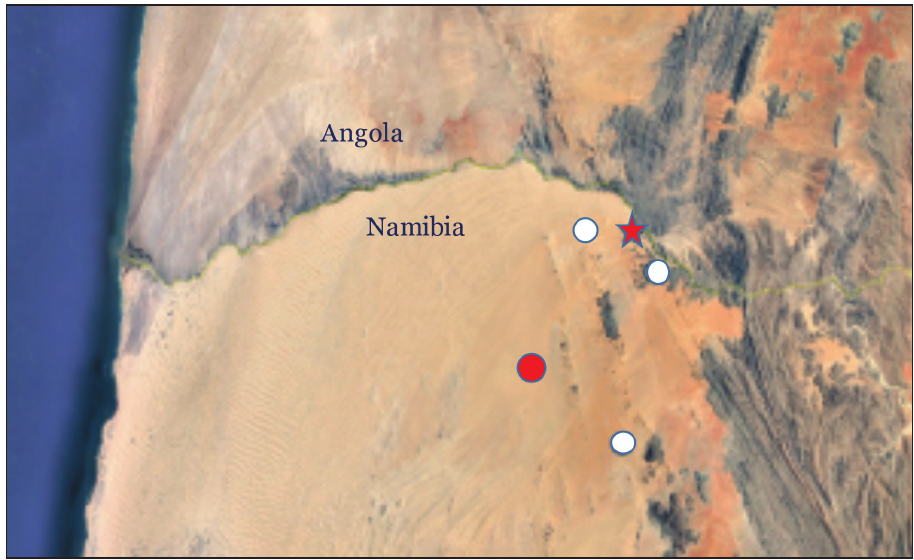
Figure 2. Map illustrating the type locality for Onymacris brainei (star), surveyed sites with appropriate habitat (white circles), and the second locality for O. brainei (red Table 1. PCR primers and amplification conditions.